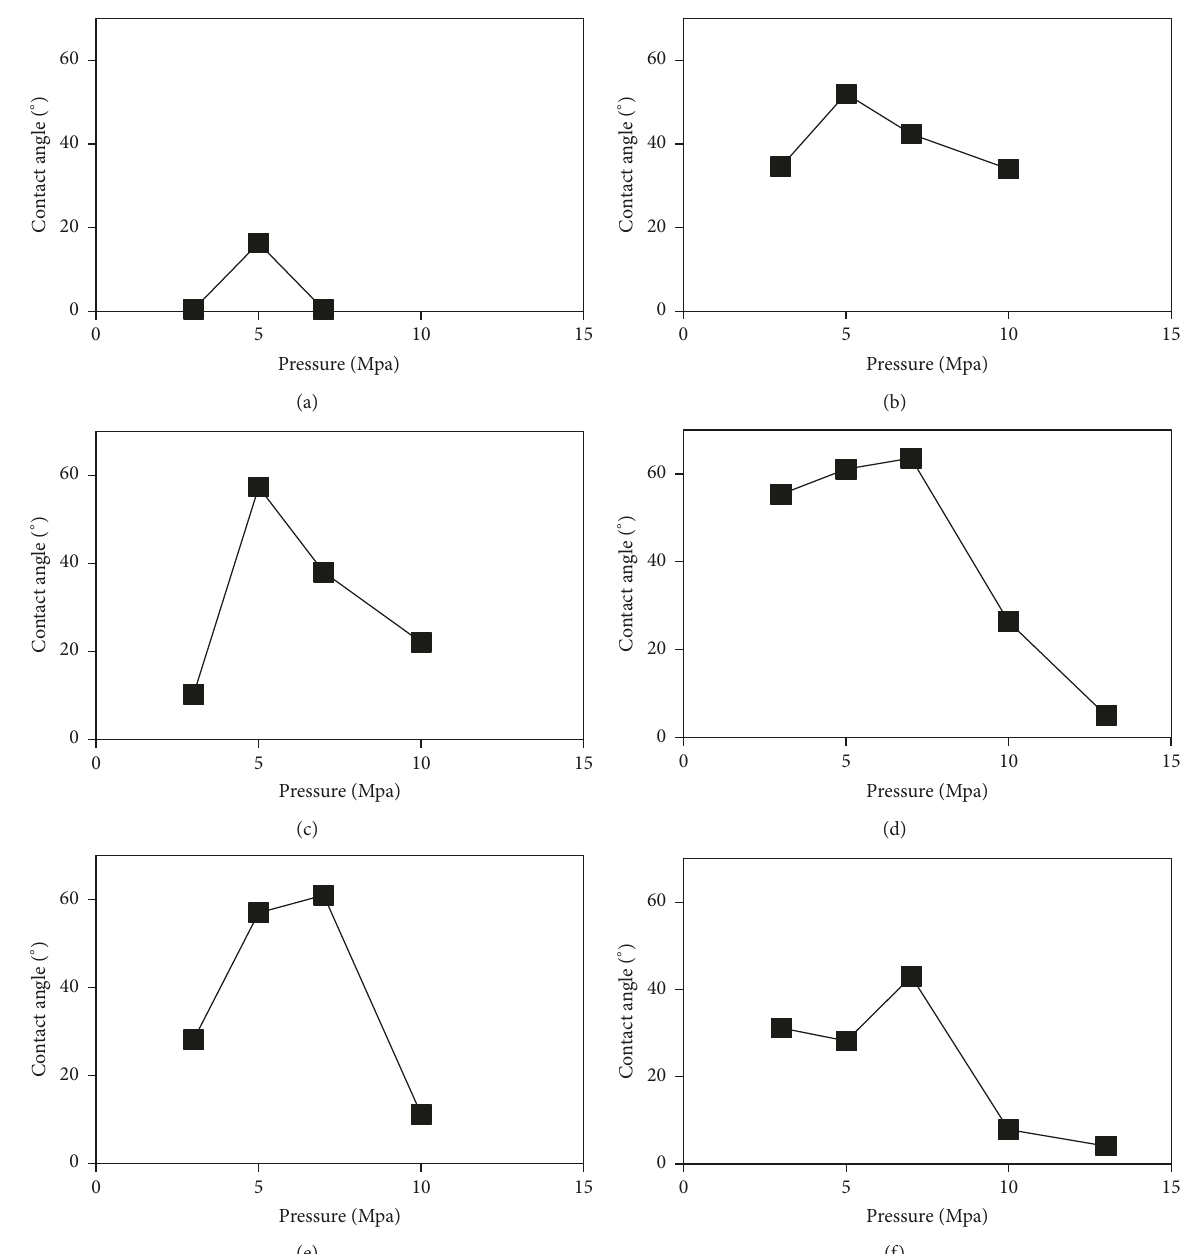
Figure 4: Difference in final and initial contact angle. (a) Type V5 with deionized water, (b) type V1 with deionized water, (c) type V5 with 1MNaCl, (d) type V1 with 1MNaCl, (e) type V5 with 3MNaCl, and (f) type V1 with